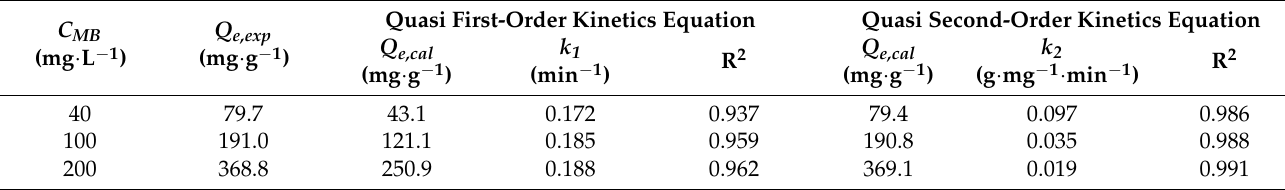
Table 3. Fitting results of kinetic equation under different concentrations.